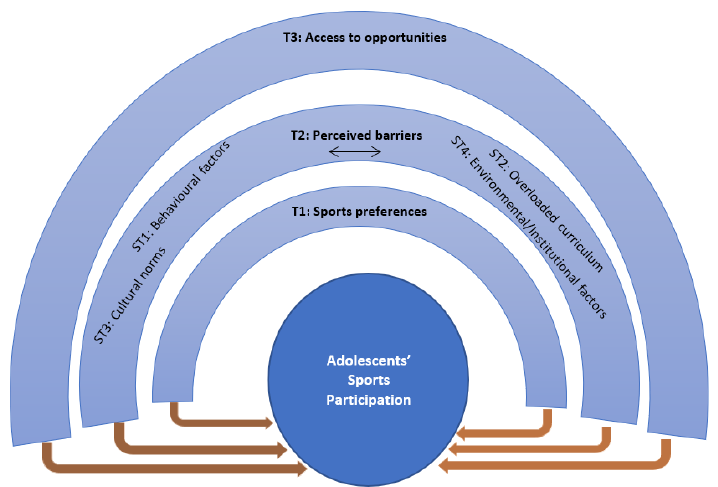
Figure 1. Thematic map of identified themes for sports participation (T: theme; ST: subtheme) .